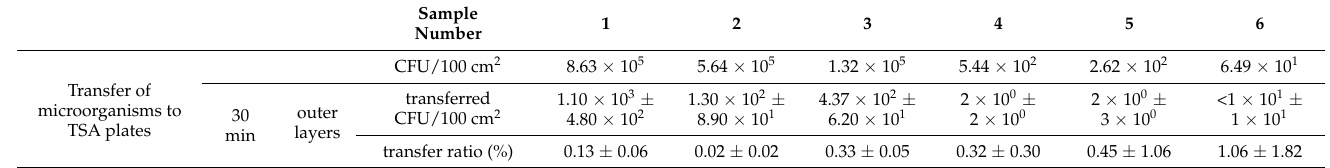
Table 6. Transfer analysis considering transfer ratios and number of CFU/100 cm 2 of tested samples to tryptone soy agar (TSA) plates. The samples are labeled with respect to their numbers of colony- forming units per 100 square centimeters (CFU/100 cm 2 ) in descending order (1–6). The experimental set-up was performed as described in Figure 2(2). Data are shown as mean ± SD. The transfer ratios are declared as a percentage (%). A p -value of <0.05 was defined as statistically